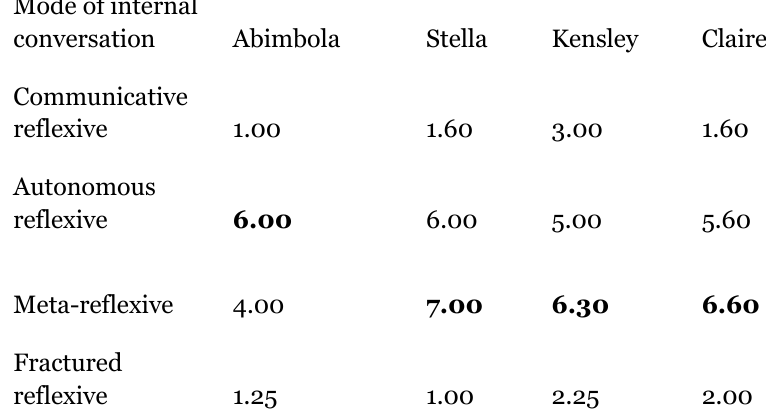
Case Study P articipants’ Ranking from ICONI Questionnaire